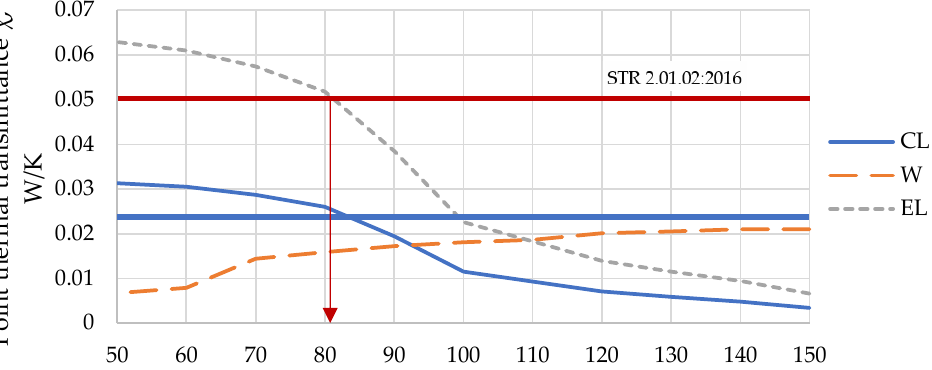
Figure 15. Compliance of the linear thermal transmittance of the investigated metal fasteners with the normative requirements.